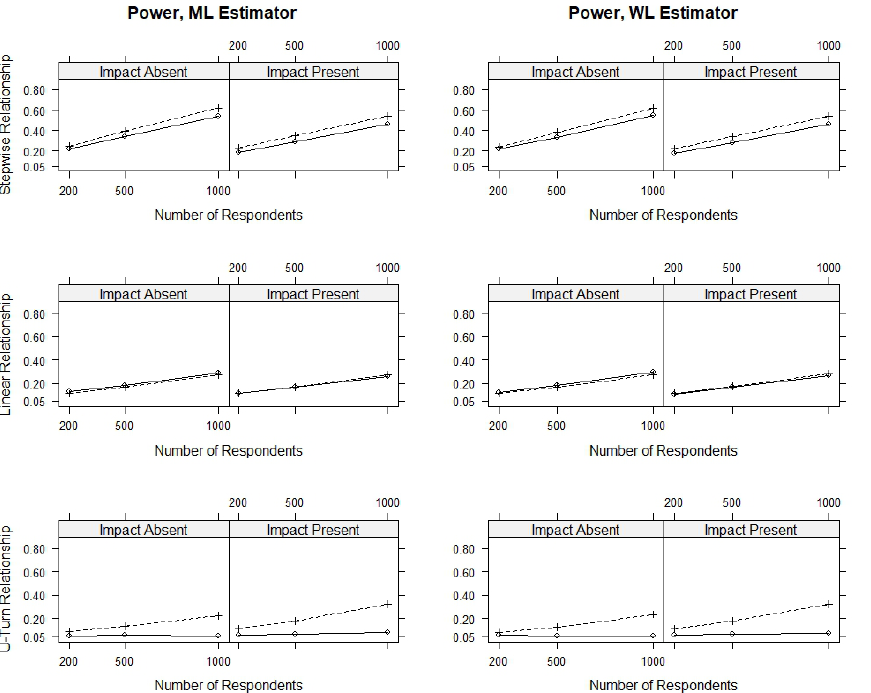
Figure A5. Power of two tests against balanced DIF in the β parameter for modules of 18 items. All items are used for ability estimation. The unbroken line presents the results for the linear logistic regression test, the broken line presents the results for the score-based bootstrap test.